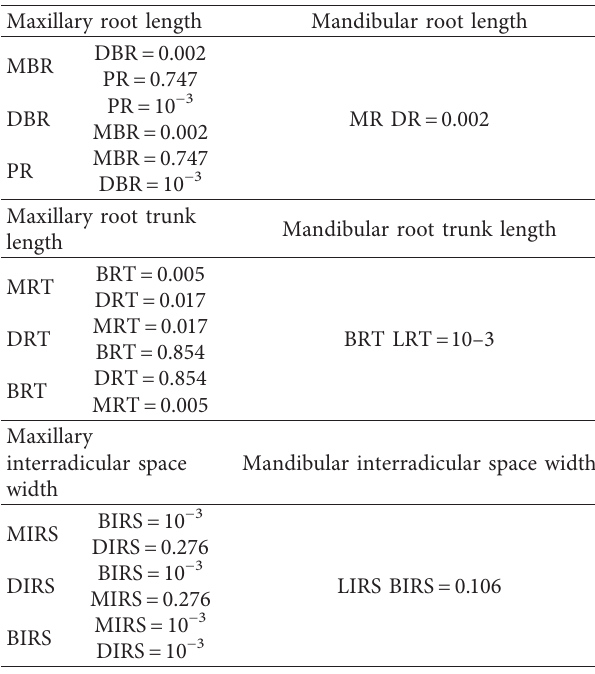
Table 3: Comparison of the different studied parameters of in- vestigated teeth. Maxillary root length